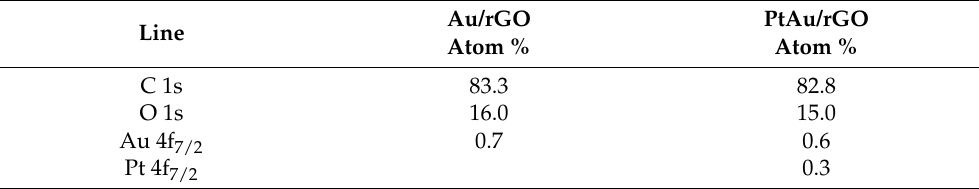
Table 2. The share of carbon, oxygen, gold, and platinum in Au/rGO and PtAu/rGO. Au/rGO PtAu/rGO Line Atom % Atom % C 1s 83.3 82.8 O 1s 16.0 15.0 Au 4f 7/2 0.7 0.6 Pt 4f 7/2